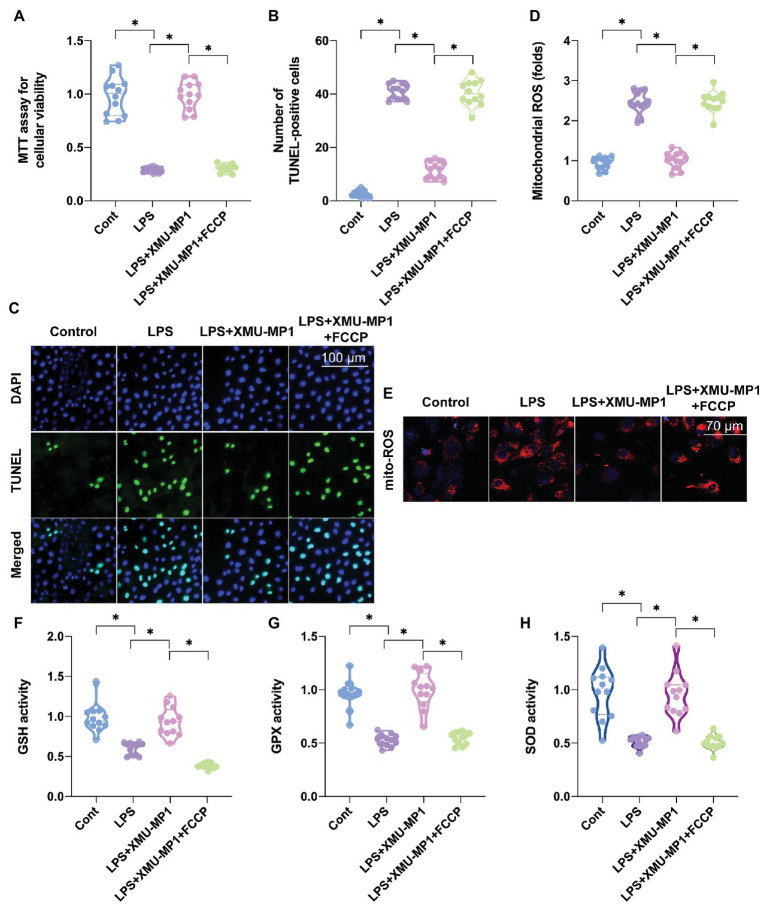
Carbonyl cyanide-4-(trifluoromethoxy) phenylhydrazone (FCCP) re-activates mitochondrial fission and abolishes the cardiomyocyte protective effects of the Mst2 inhibitor. (A) MTT assay results show the viability of control, LPS-treated, XMU-MP1 plus LPS-treated, and FCCP plus XMU-MP1 plus LPS-treated H9C2 cells. (B,C) TUNEL staining images and quantification of percent TUNEL+ (apoptotic) cells in the control, LPS-treated, XMU-MP1 plus LPS-treated, and FCCP plus XMU-MP1 plus LPS-treated H9C2 cardiomyocyte groups are shown. (D,E) Immunofluorescence analysis shows the Mitosox red (mitochondrial ROS-sensitive dye)-stained control, LPS-treated, XMU-MP1 plus LPS-treated, and FCCP plus XMU-MP1 plus LPS-treated H9C2 cardiomyocyte groups. (F–H) ELISA assay results show the levels of antioxidant enzymes, namely, GSH, SOD, and GPX in the control, LPS-treated, XMU-MP1 plus LPS-treated, and FCCP plus XMU-MP1 plus LPS-treated H9C2 cardiomyocyte groups. Cardiomyocytes were treated with LPS for 24 h. Mst2 blocker (XMU-MP1) was used to incubate with cardiomyocyte before LPS treatment. FCCP was used to increase mitochondrial fission. *
p < 0.05.